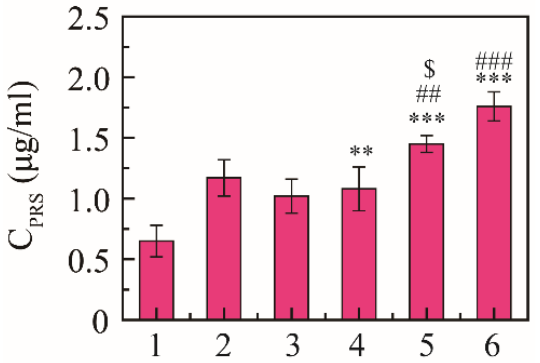
Figure 5. Expectorant activities of NRG-NSps ( n = 8). 1: Saline group, 2: ambroxol hydrochloride group (15 mg/kg), 3: NRG group (30 mg/kg), 4: NRG-NSps group (10 mg/kg), 5: NRG-NSps group